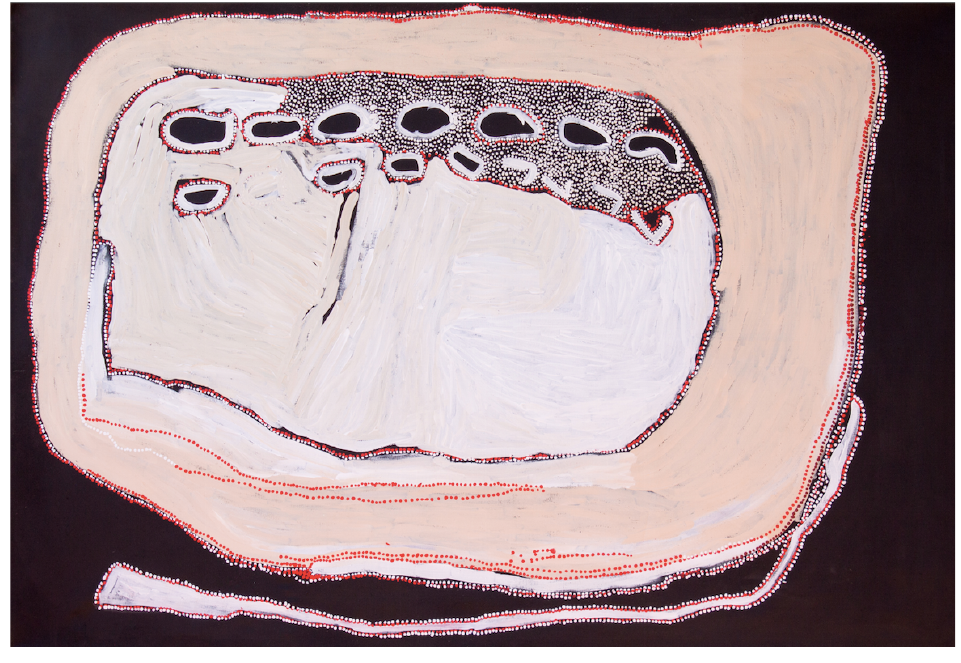
Carlene West, Tjitjjiti , 2014, acrylic on linen, 200 x 137 cm. Private collection (photo: courtesy